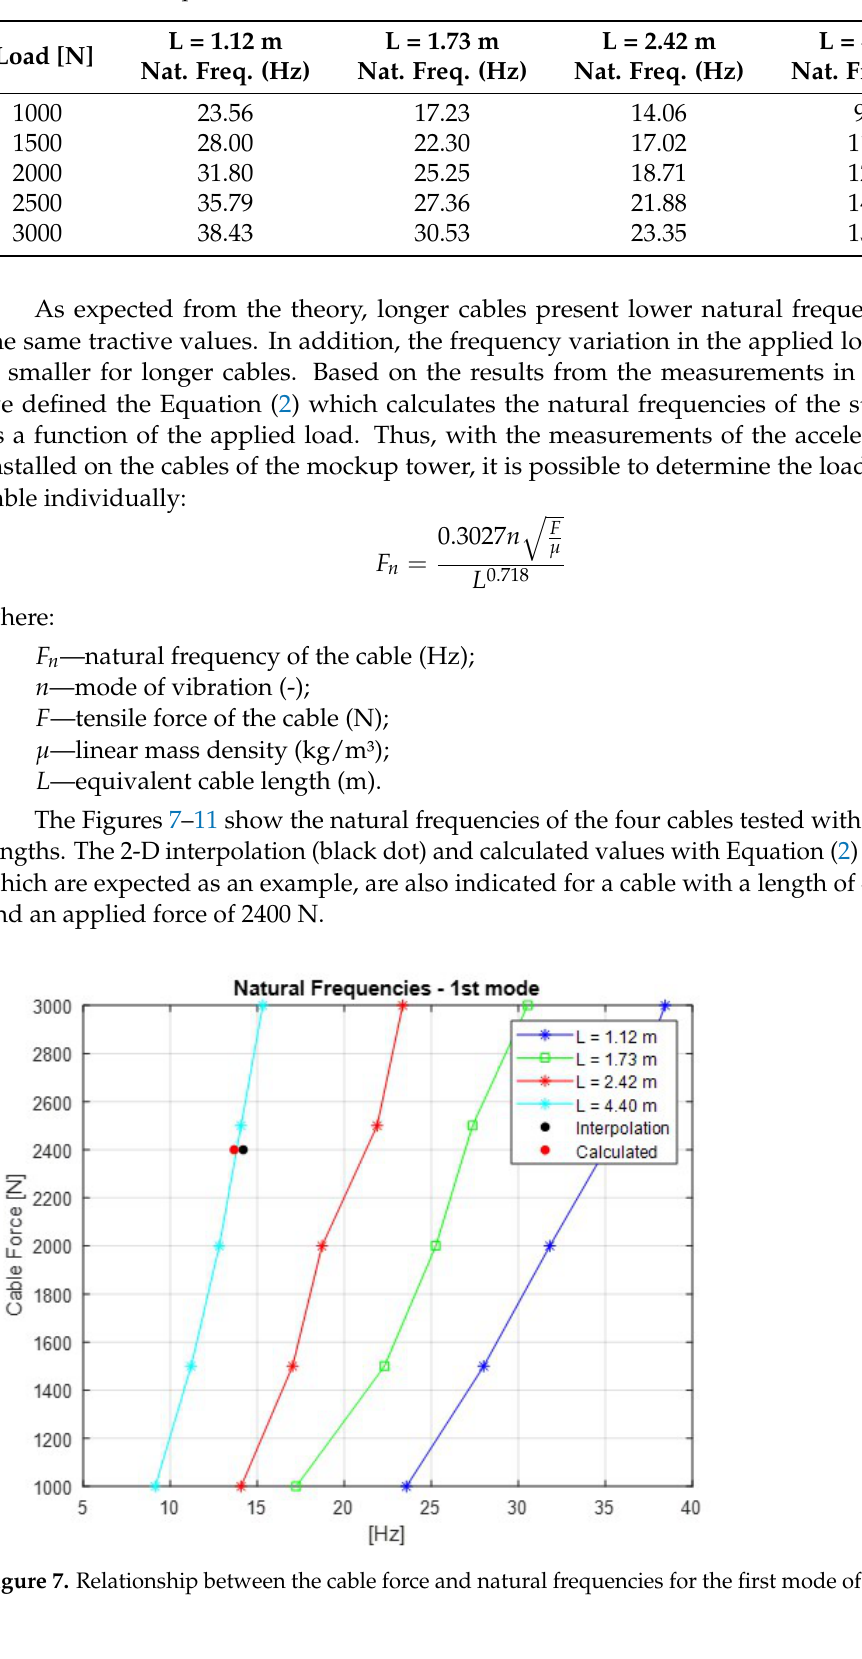
Table 3. Natural frequencies of the first mode as a function of cable force.